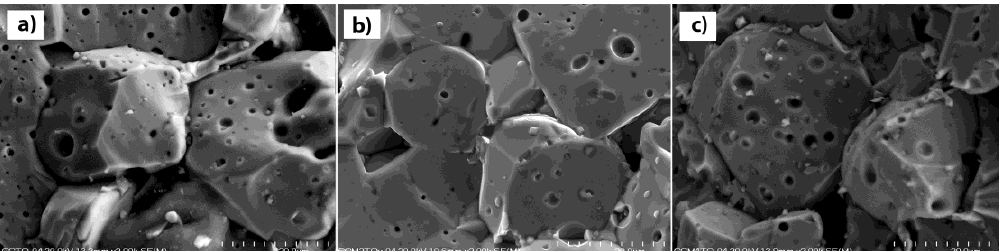
Figure 4. SEM photographs of the surface of the CaCu 3−x Mg x Ti 4 O 12 samples sintered at 1075 °C for 10 h where ( a ) x = 0.0; ( b ) x = 0.2; ( c ) x = 0.4 .